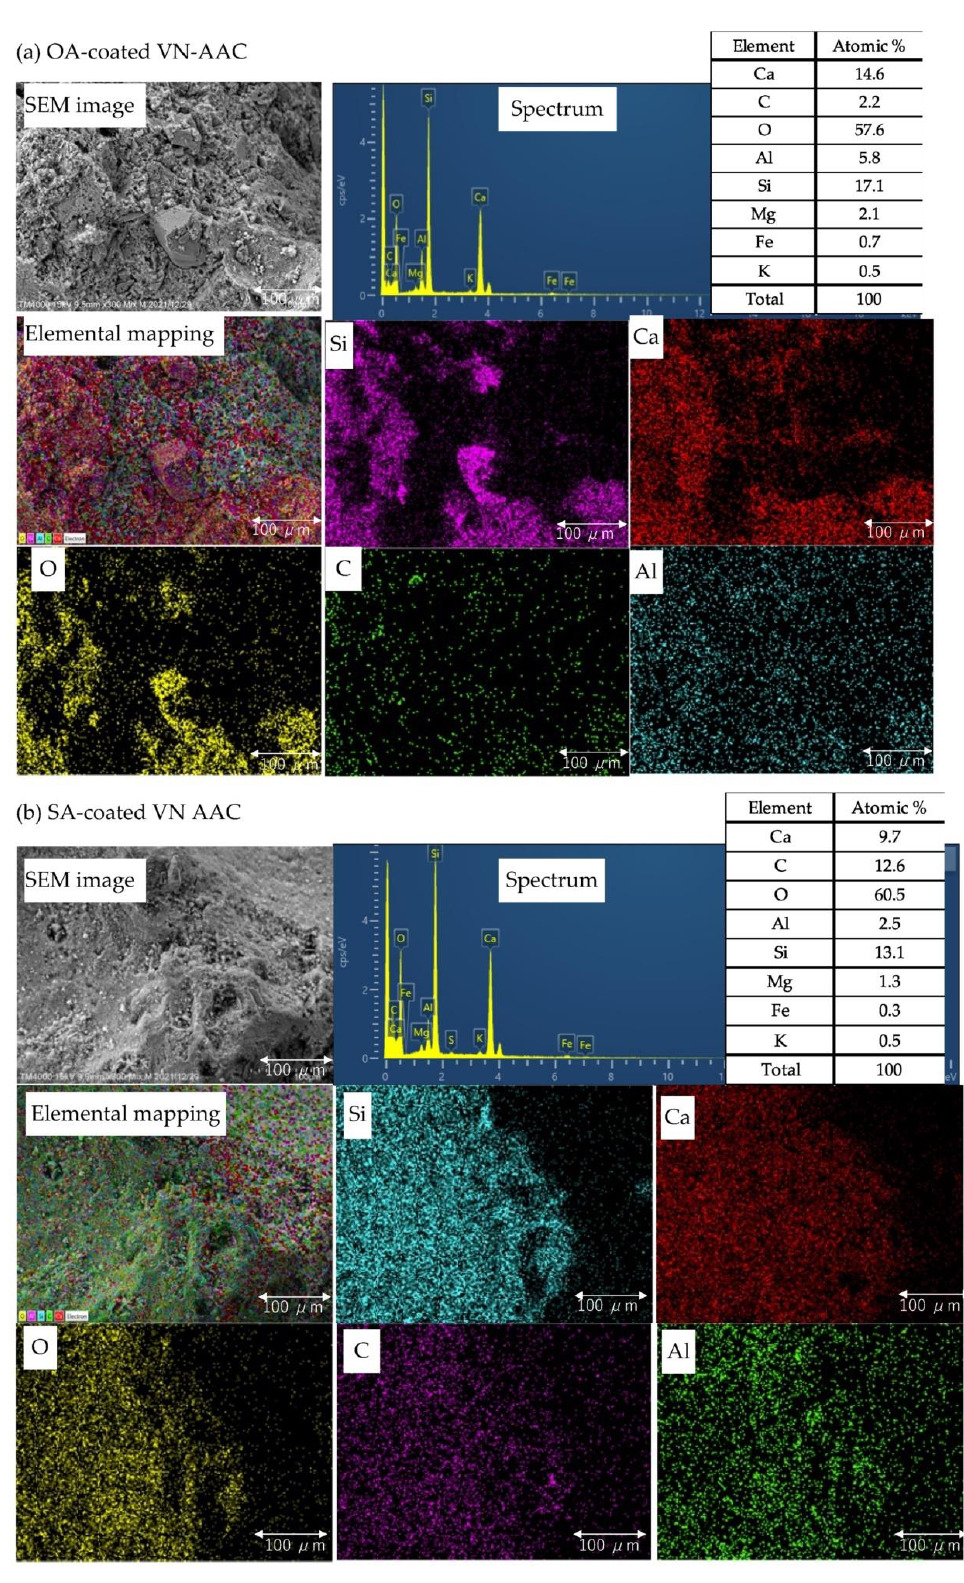
Figure 3. SEM-EDS images of ( a ) OA-coated VN-AAC grain (0.85 – 2.00 mm) at HA concentration = 14 g/kg and ( b ) SA-coated VN-AAC grain (0.85 – 2.00 mm) at HA concentration = 42 g/kg.